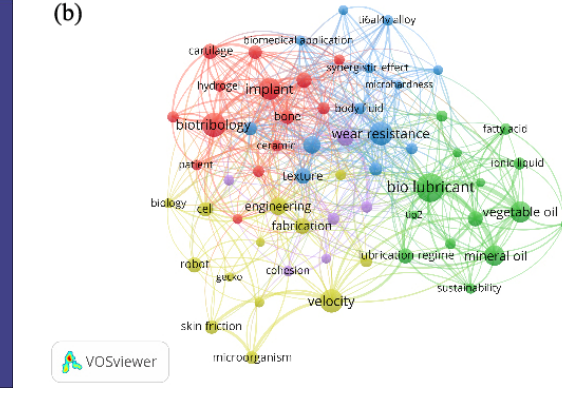
Fig. 38 (a) Density and (b) network diagrammes of biotribology.